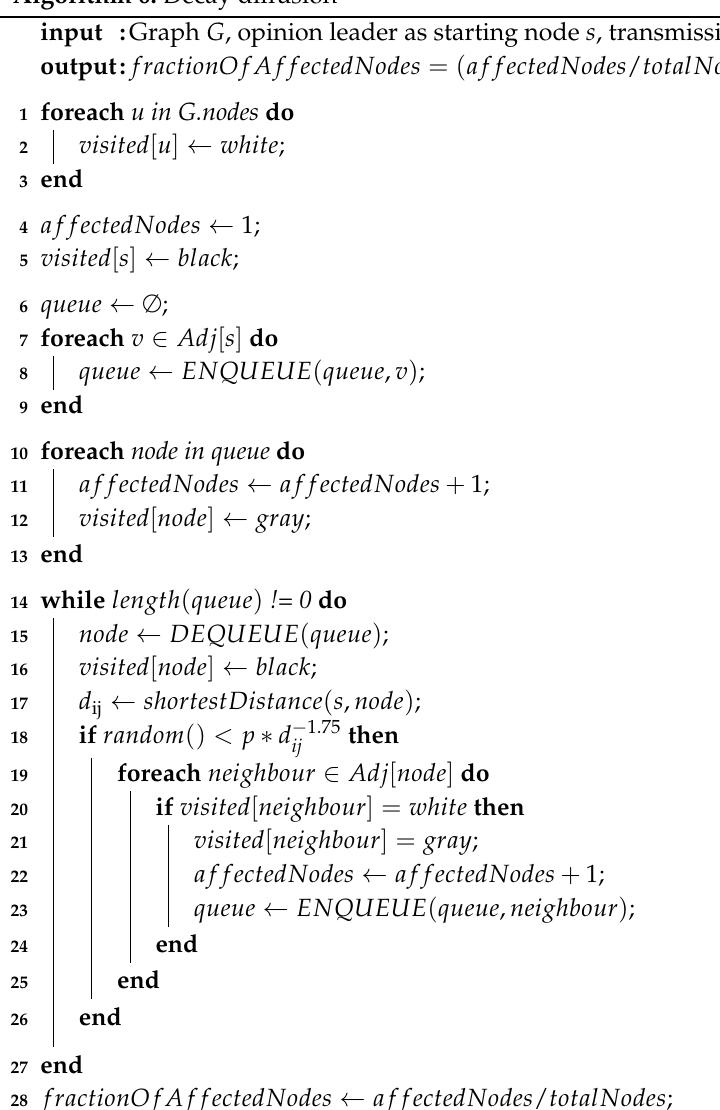
Algorithm 6: Decay